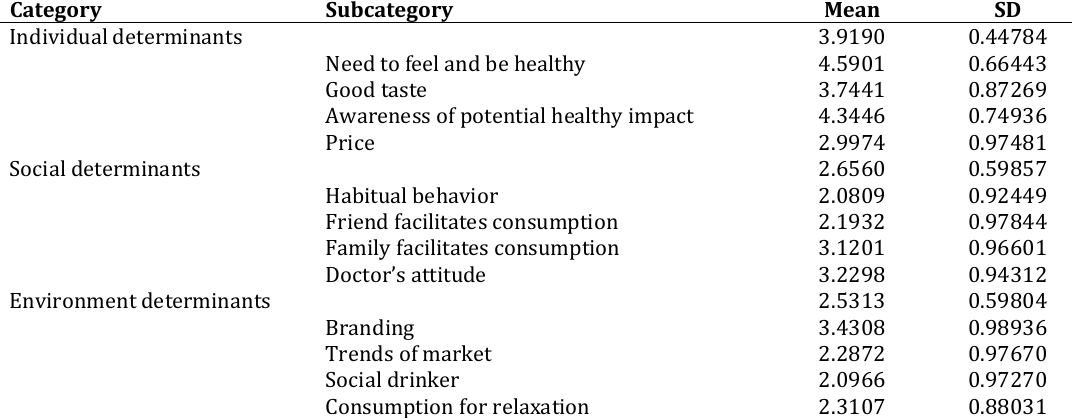
Table 1: Factors that affect healthy beverage consumption for aging consumers